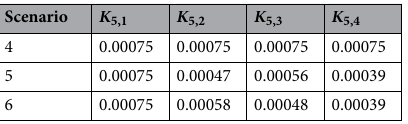
Table 9. BELBIC controller parameters for each operating